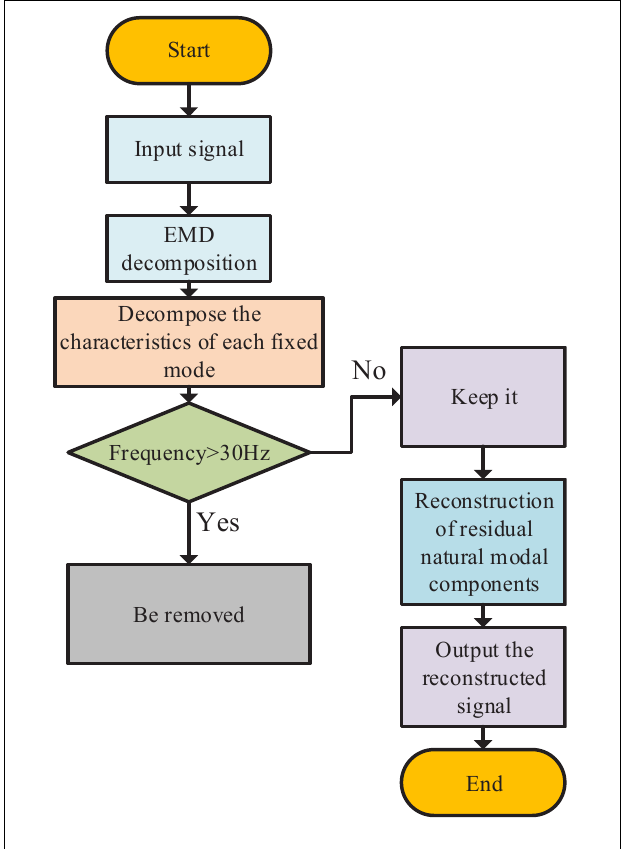
FIGURE 4 | Denoising